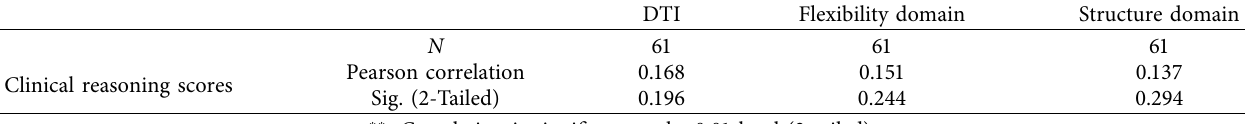
Table 7: A correlation matrix of students’ clinical reasoning scores and their diagnostic thinking and